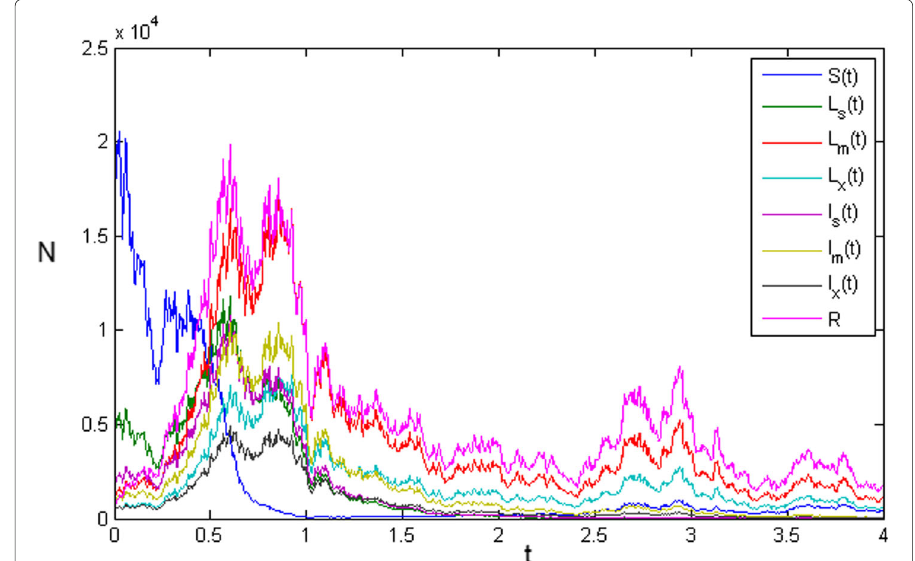
Fig. 1 Simulations of multi-strain TB model showing the various classes with θ = 0, ξ =